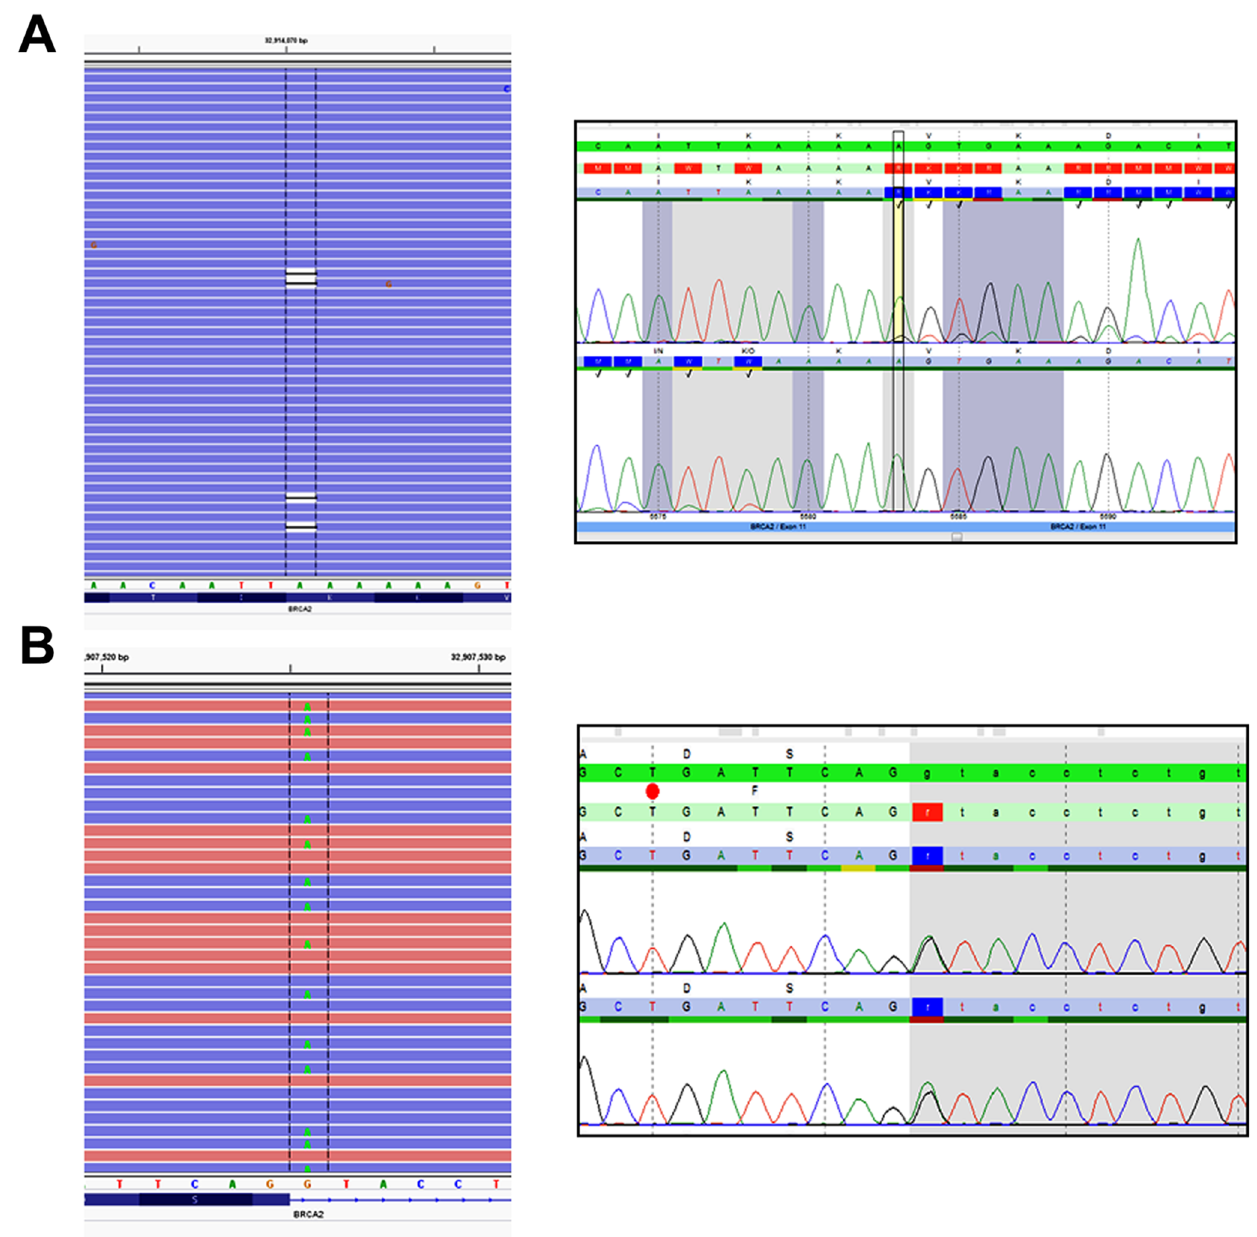
Figure 8. Causative heterozygous mutations, which had previously gone undetected, identified with BRCAplus assay. A) Mosaic pathogenic mutation c.5583delA in BRCA2 was detected at allele ratio of 14.9% and confirmed by Sanger sequencing. B) A heterozygous splice site mutation c.1909 + 1 G . A in BRCA2 , was detected by BRCAplus assay.